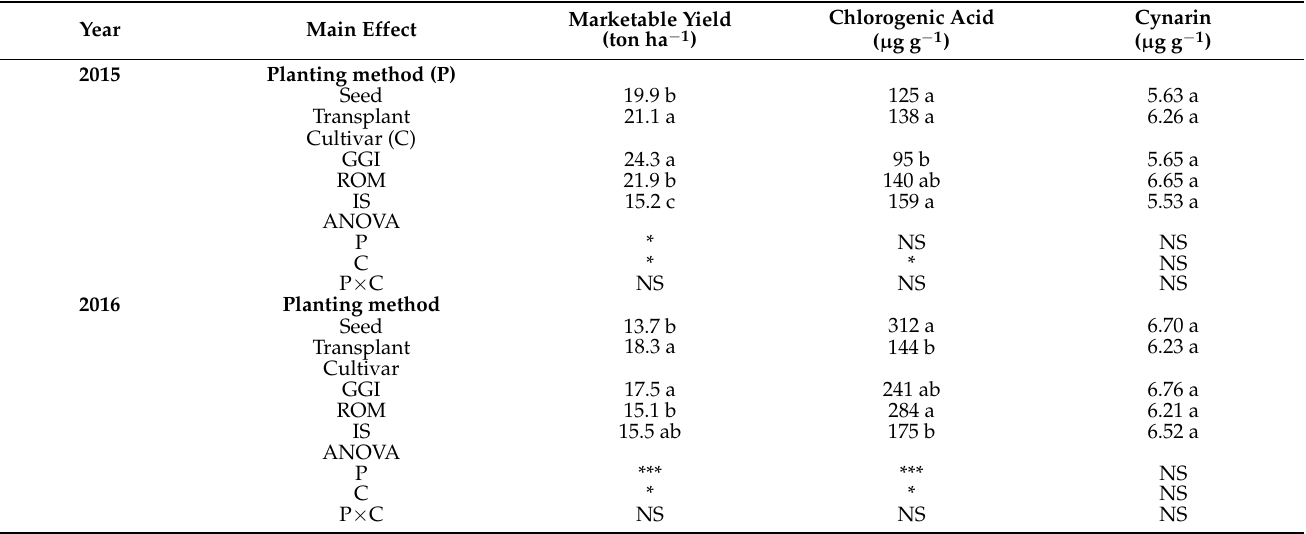
Table 4. Marketable yield, chlorogenic acid, and cynarin of artichoke cultivars (Green Globe Improved (GGI), Romolo (ROM), and Imperial Star (IS)) as influenced by planting method (direct seeding—Seed, and transplanting—Transplant) during 2015 and 2016 seasons.